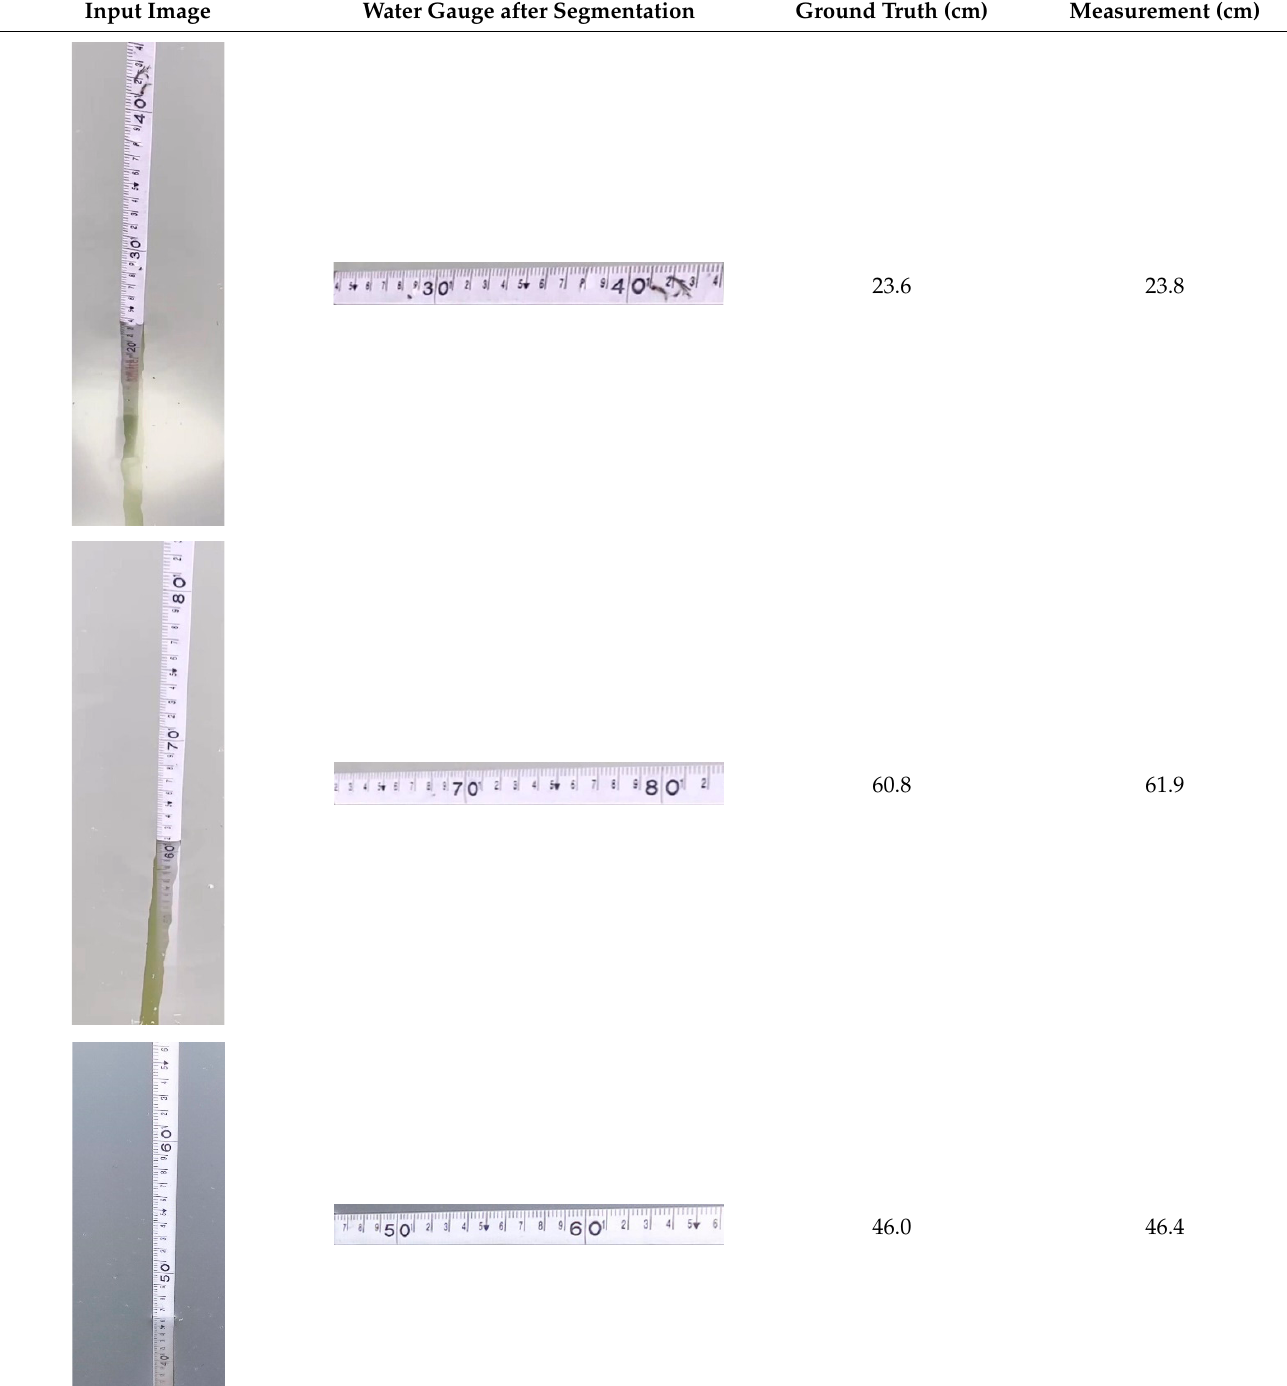
Table 6. Water gauge reading calculation test results.